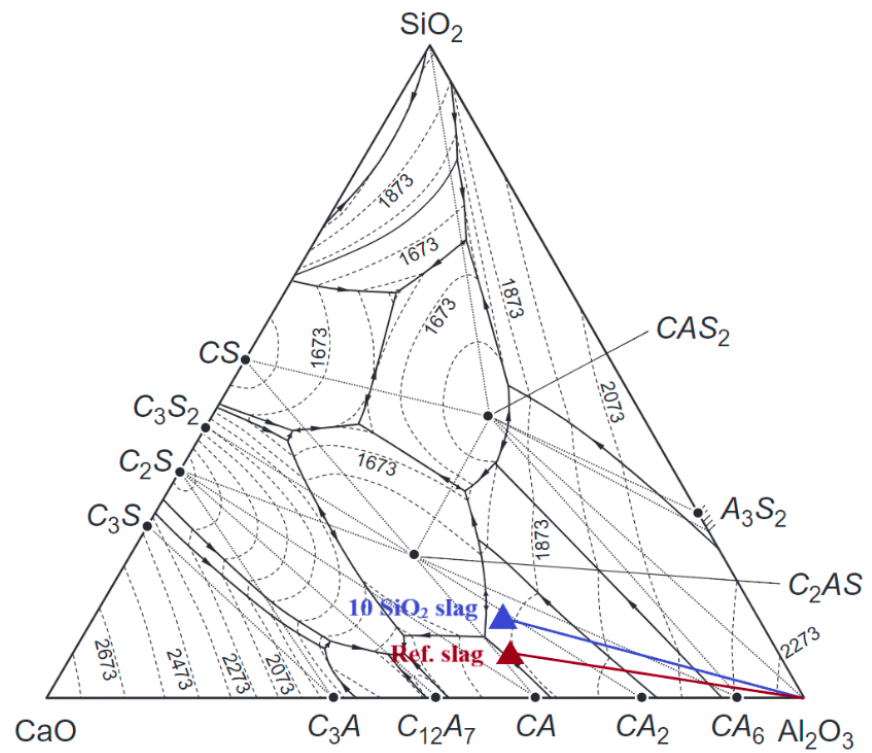
Figure 18. Ternary phase diagram of CaO-Al 2 O 3 -SiO 2 [25]. The starting compositions of the slag R (Ref. slag) and slag S (10SiO 2 ) are indicated in the diagram.